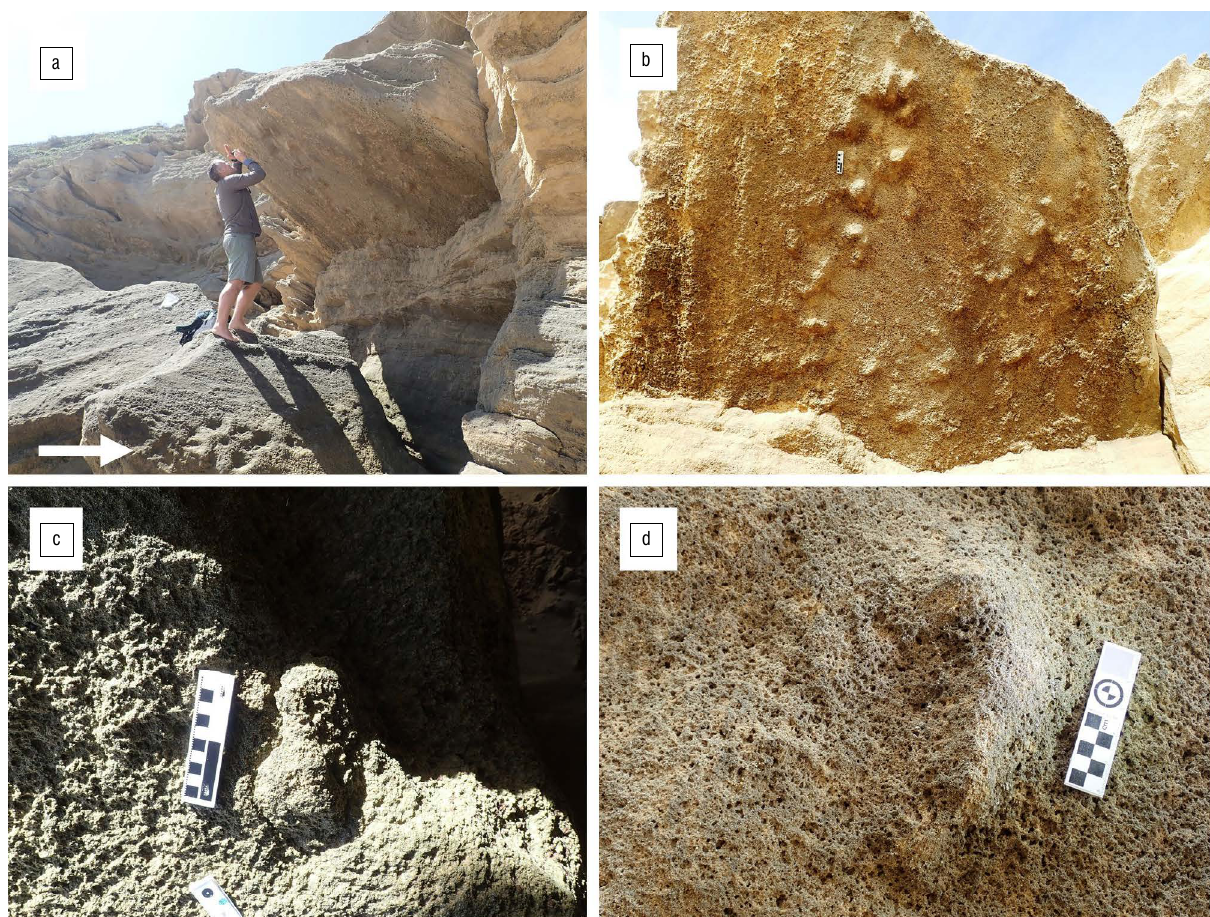
Figure 6: (a) The figure is standing on the top of the loose slab containing the tracks in epirelief (indicated by arrow) and analysing the tracks on the hyporelief surface. (b) The hyporelief surface of Site 2, viewed from a distance. (c) Close-up view of the track that is only evident on the epirelief surface. (d) Close-up view of Track A7.